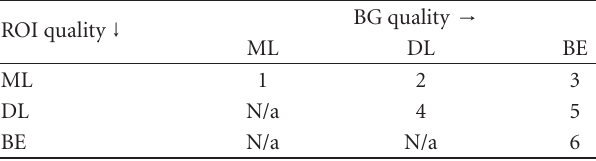
Table 4: Encoder state